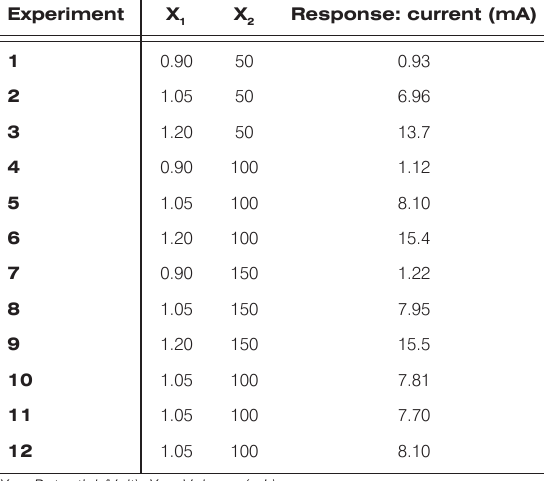
Table 2. Experimental design 3 2 and responses.